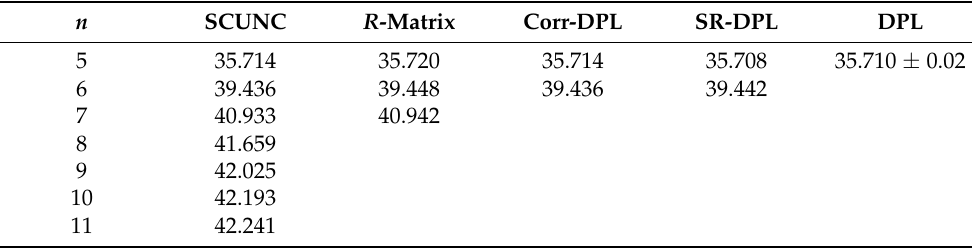
Table 7. Resonance energies (in eV) of the 4s4p 6 ( 2 S 1/2 ) n p 1 P ◦ 1 Rydberg series of Rb + converging to the Rb 2+ (3d 10 4s4p 6 2 S 1/2 ) threshold. The SCUNC results are compared to the synchrotron radiation (SR) and dual laser plasma (DPL) measurements of Kilbane et al. [9] along with the dual laser plasma (DPL) data of Neogi et al. [26] and corrected dual laser plasma (Coor-DPL) data of Neogi et al. [26] by Kilbane et al. [9] and with the Dirac R -matrix calculations of McLaughlin and Babb [17].